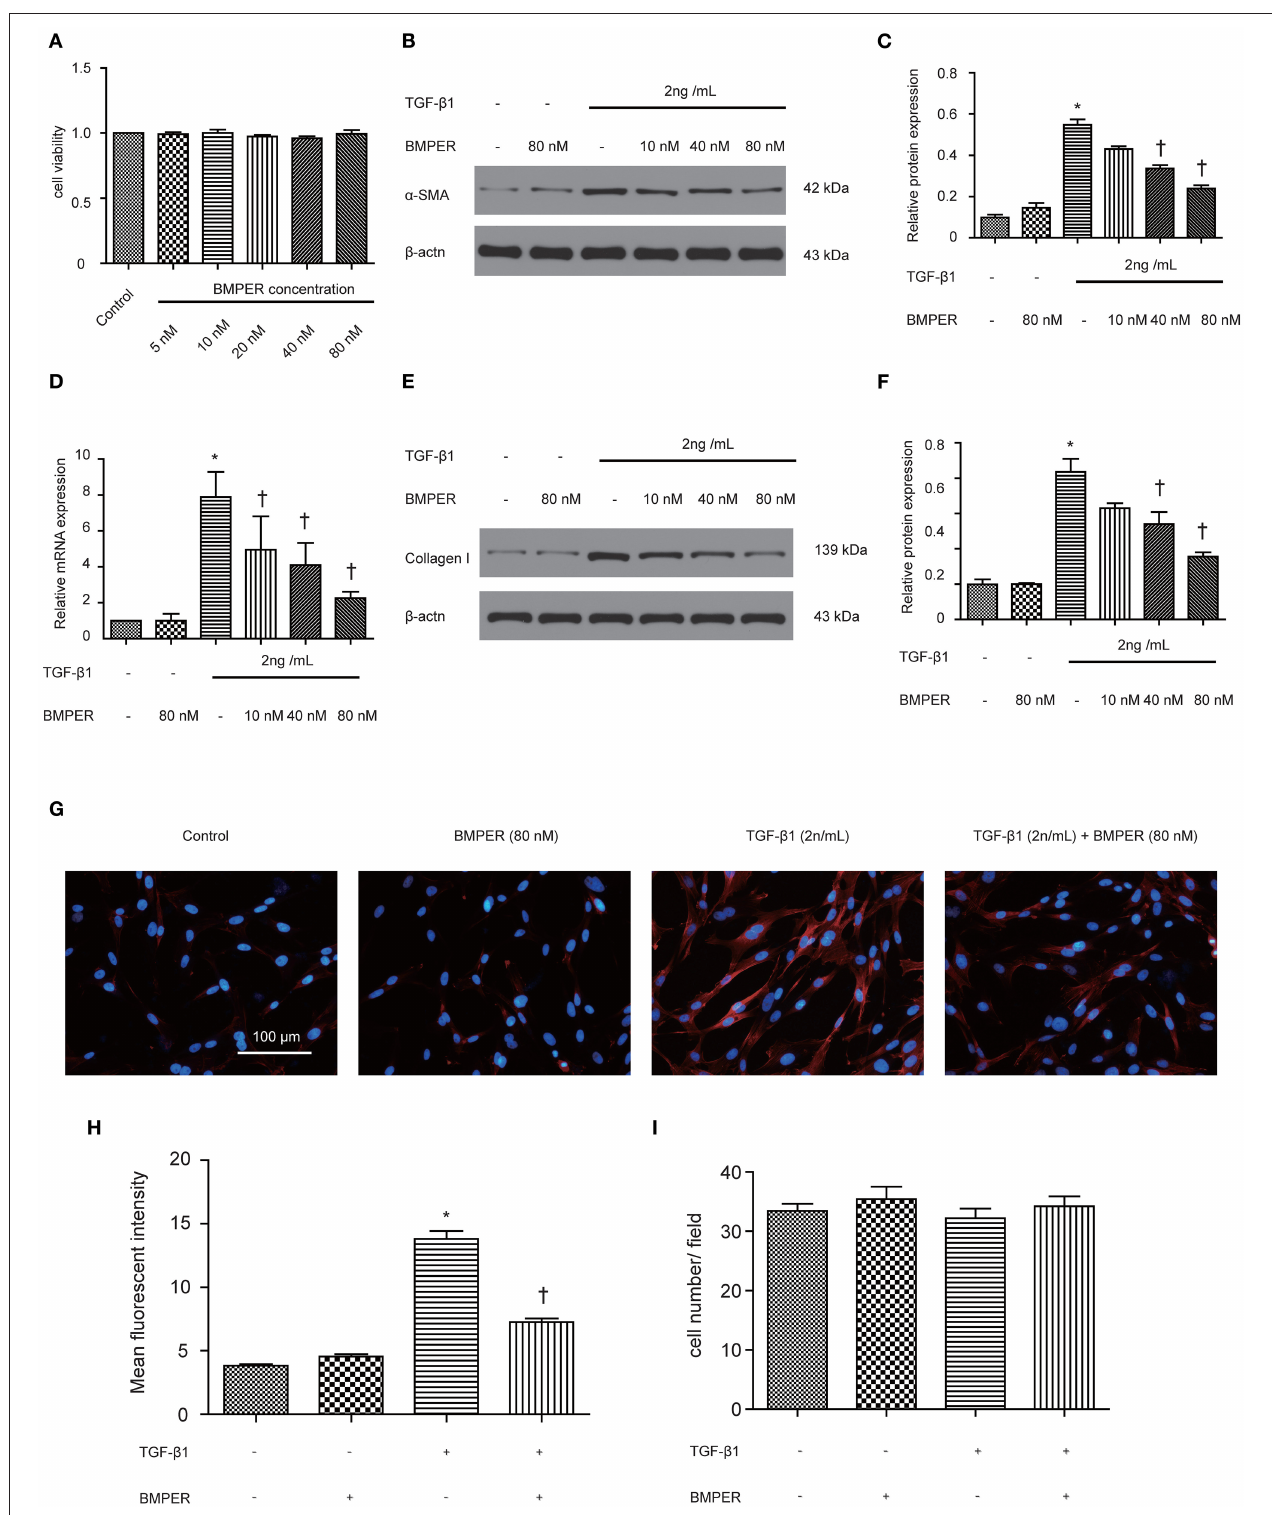
FIGURE 4 | Exogenous BMPER prevented fibroblast activation. NRK-49F cells were incubated with increasing amounts of BMPER (5–80 nmol), and cell viability was detected by MTT (A) NRK-49F cells were incubated with a fixed amount of TGF- β 1 (2ng/ml) and increasing amounts of BMPER as indicated for 48h, and α -SMA